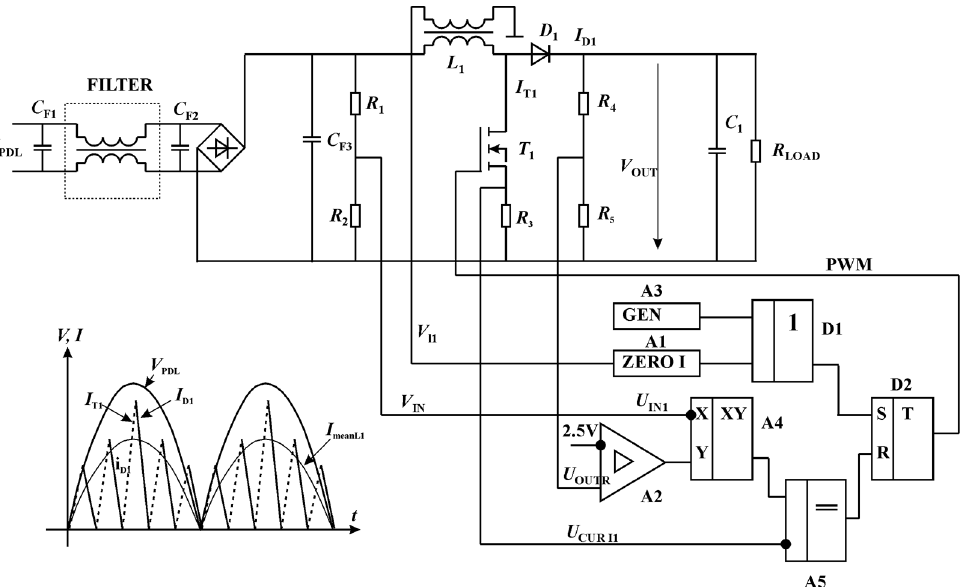
Figure 4. Electrical diagram and time diagrams of LED power supplies with the PFC correction.